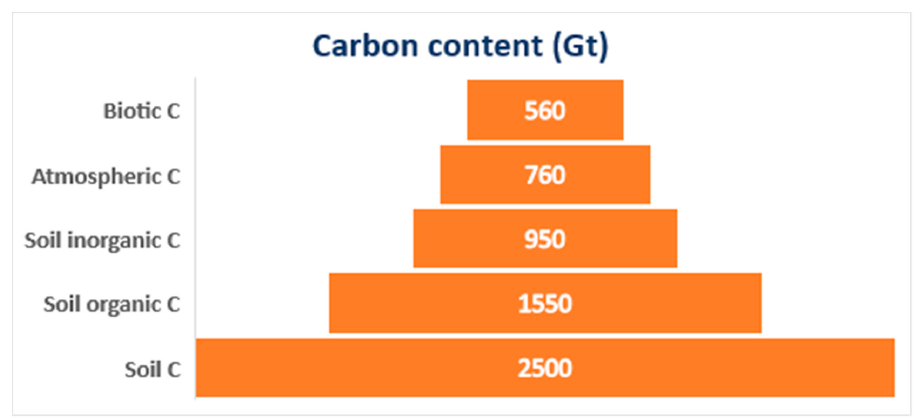
Figure 1. Carbon content in soil, atmosphere and biota based on Lal (2004) [28].